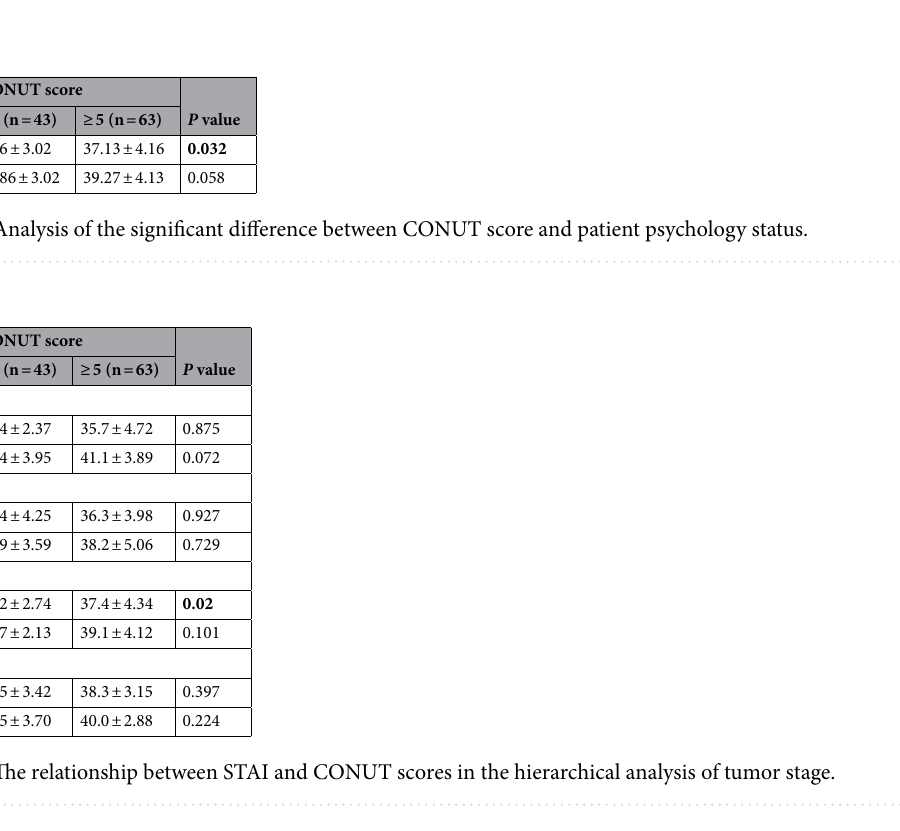
Table 5. Univariate and multivariate analyses of complications.